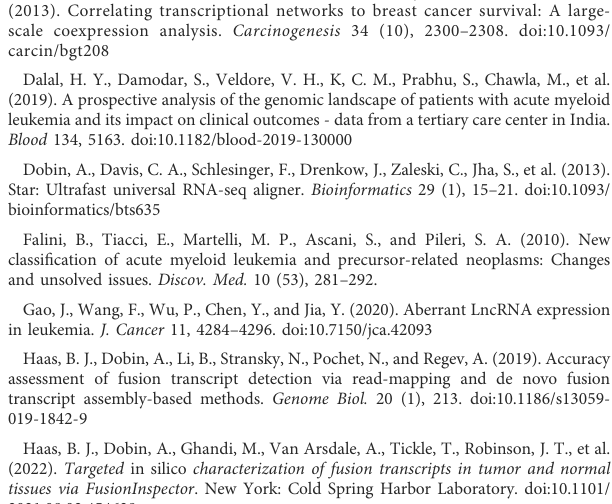
SUPPLEMENTARY FIGURE S5 Bar chart showing signi fi cantly enriched pathways obtained using the genes of the “ black ” module correlating to the BCR group of samples. SUPPLEMENTARY FIGURE S6 CCL28 and DOCK2 expression patterns across all the AML patients with upregulationspeci fi ctotheHOXD11-AGAP3categoryofpatientsalongwith a Kapalan-Meier curve of CCL28 in AML from GEPIA betweenlow and high CCL28 expression groups. SUPPLEMENTARY TABLE S1 Number of reads mapping to the Fusion Junctions in respective